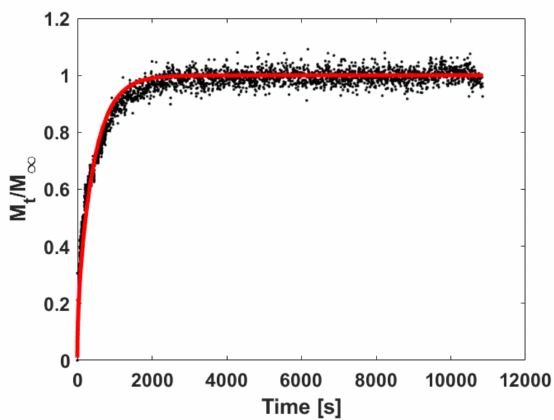
Figure 3. Fitting of sorption kinetics data of n-hexane for the pressure step from 405 to 576 mbar at 115 ◦ C. Red continuous line is the result of data best fitting with Equation (19).